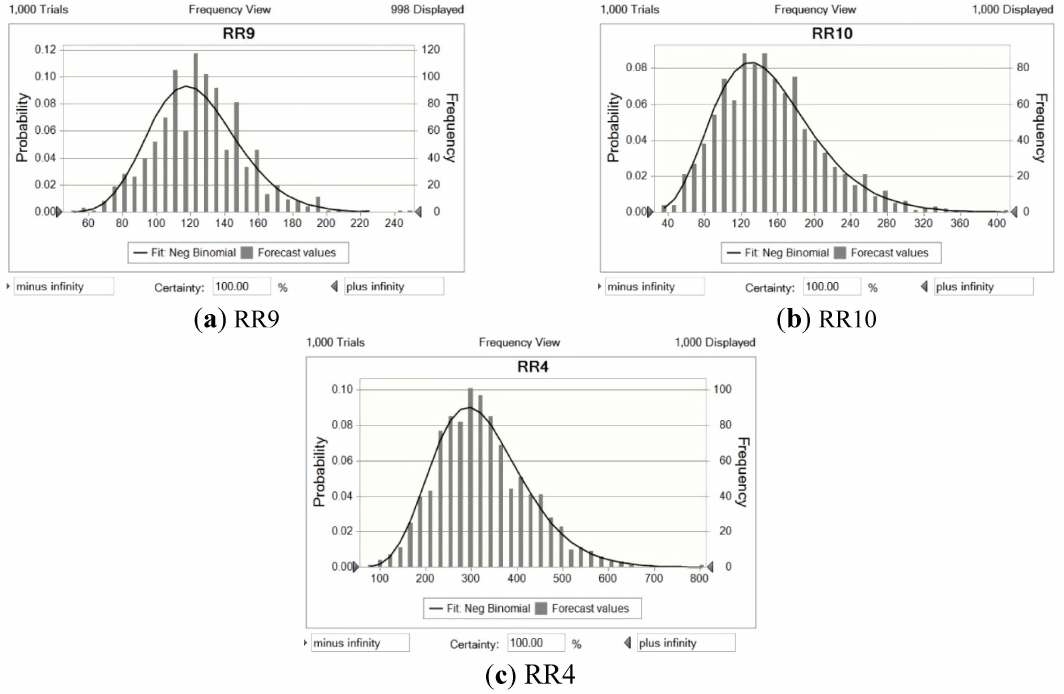
Figure 7. Uncertainty analysis result: risk probability distribution for region ( a ) RR9; ( b ) RR10; and ( c ) RR4.